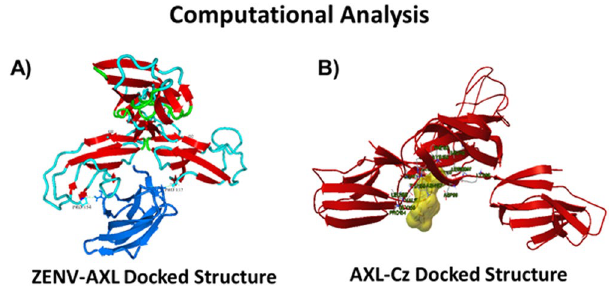
Figure 3. ( A ) ZENV-DIII-AXL-D1D2 docked structure. The ZENV-DIII domain is shown in blue. ZENV-DIII lies in a pocket of AXL-D2 residues, resulting in a binding equilibrium value for ZENV-AXL of 2.8E − 6 M. ( B ) Vina-generated docking structure of Crizotinib with AXL. The corresponding binding free energy = − 7.3 kcal/ mol when Crizotinib binds to the same pocket as